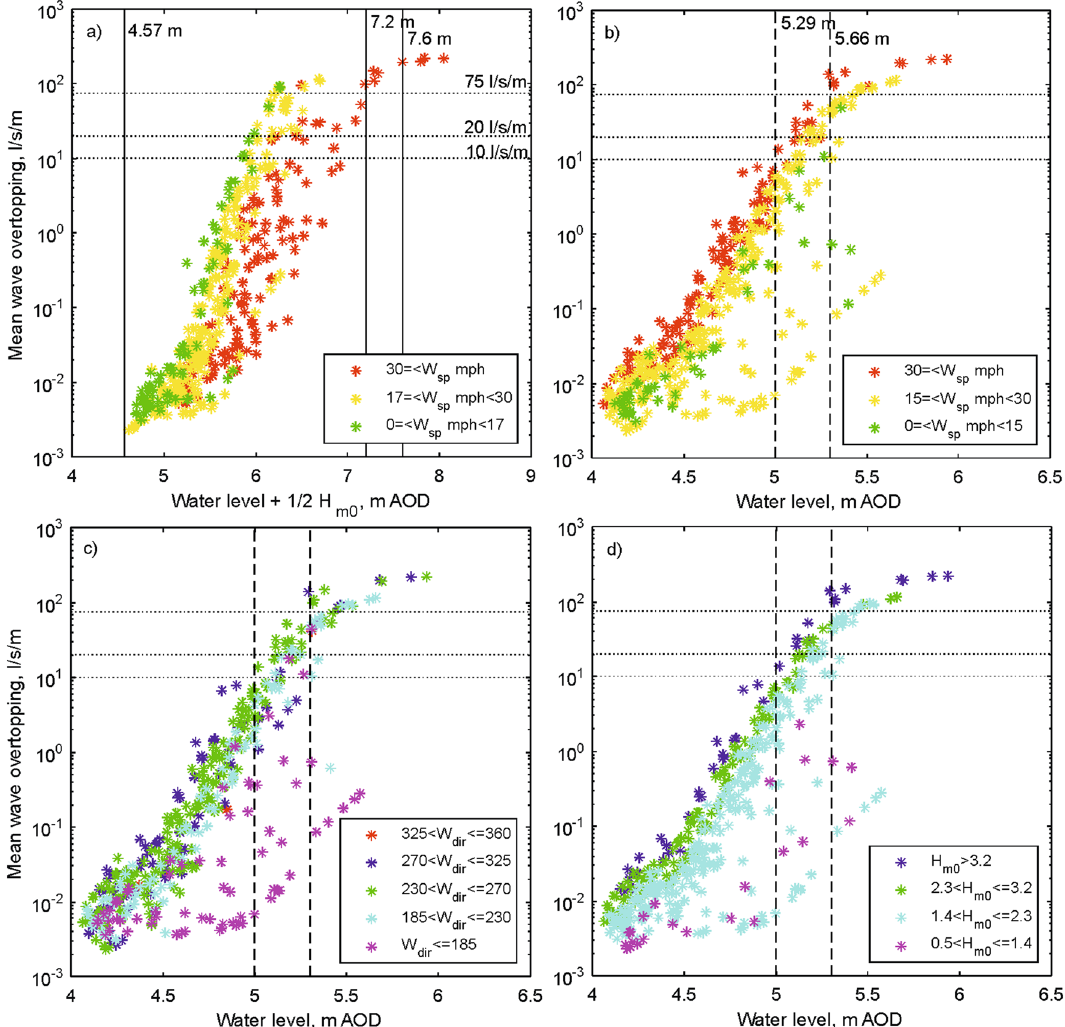
Figure 6. Predictions of overtopping for the Facebook events. The horizontal lines show the EurOtop hazard thresholds for pedestrians (10 to 20 l/s/m) and vehicles (20 to 75 l/s/m). ( a ) The typical management approach to hazard classification (vertical lines indicate the hazard criteria), based on a combination of water level and offshore wave heights. The colours show wind speed classes for onshore wind directions. In contrast, the operational approach of the LA is based on water level without offshore wave heights. The colours show the influence of ( b ) wind speed (W sp ) and ( c ) wind direction (W dir ), and ( d ) the associated offshore wave heights (H m0